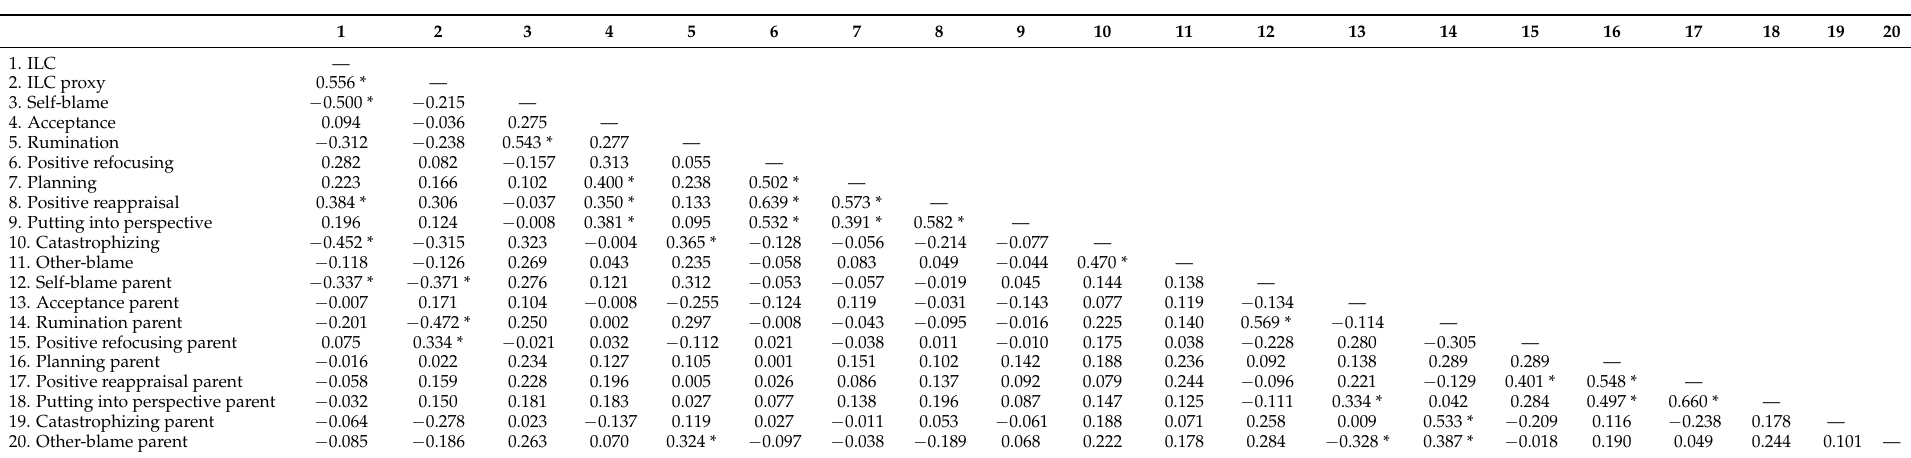
Table 3. Bivariate relationships (Pearson’s correlation coefficients) of study variables ( n =